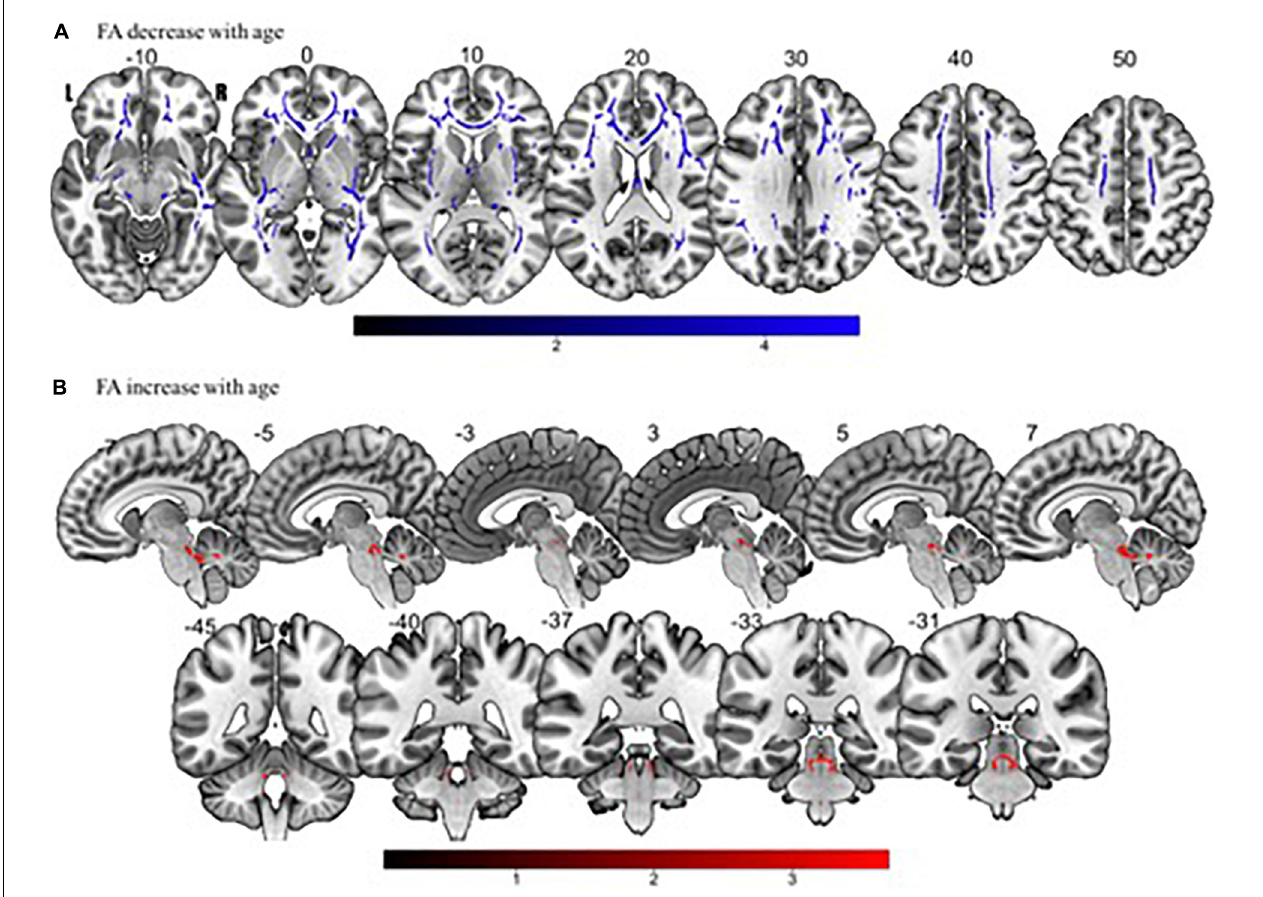
FIGURE 6 | Significant correlations between (A) FA decrease with age and (B) FA increase with age ( p < 0.05, cluster-wise FDR corrected for multiple comparisons). Pictures are in neurological convention with left side in the figure corresponding to the left side of the